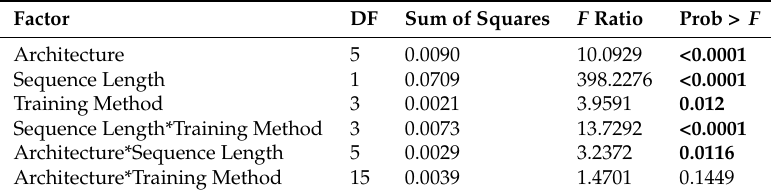
Table 3. Results of the 3-factor ANOVA evaluating the effects of architecture, sequence length, training method, and first-order interactions on mean classification accuracy. Significant results are displayed in bold .